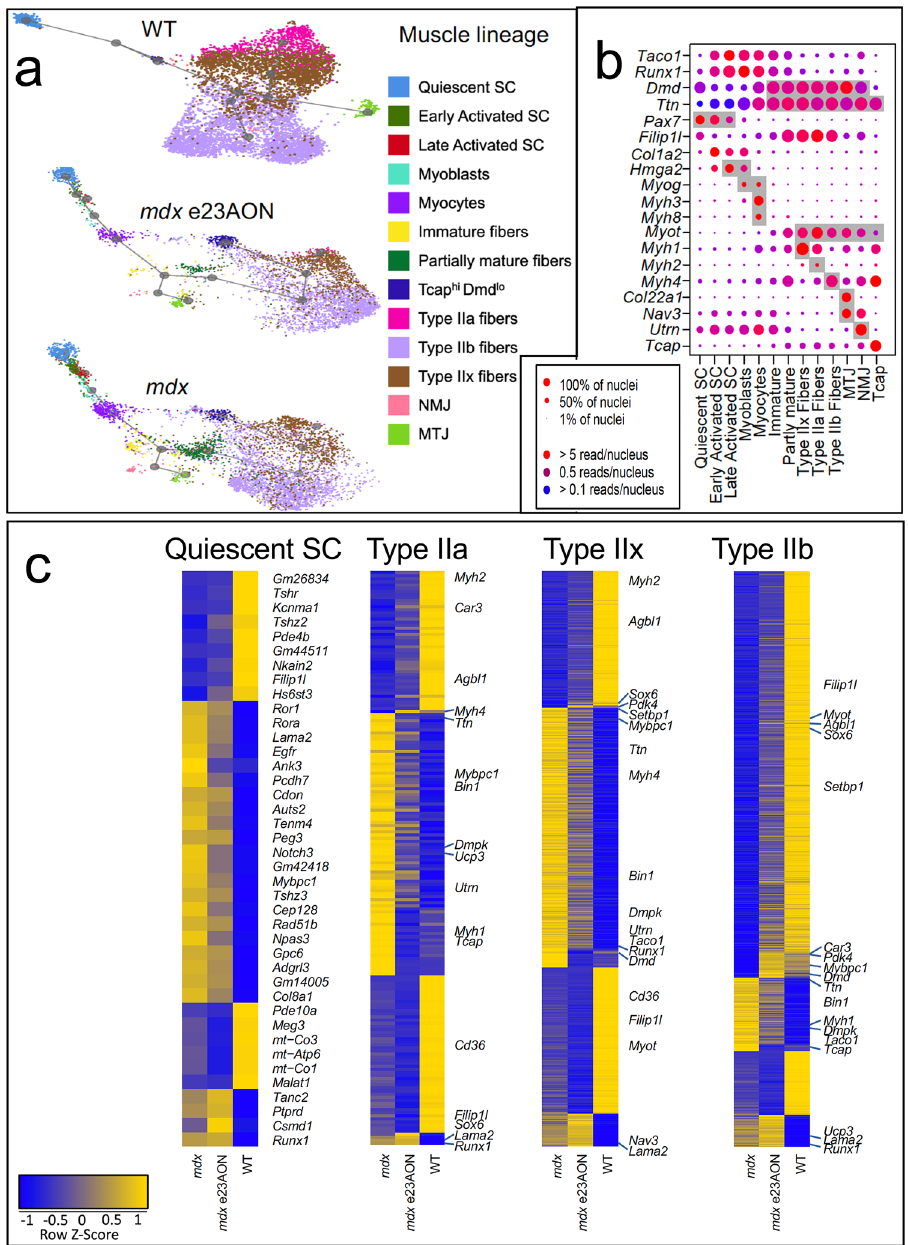
Fig. 3 Murine muscle lineage disease-related cell type and transcriptomic changes. a U-map pseudotime analysis and lineage tracing of muscle cell types was performed for WT ( n = 3), mdx e23AON ( n = 4), and mdx ( n = 4) nuclei. Muscle cell types are arranged according to their transcriptional relatedness and subcluster color is matched to legend for cell types shown in a and b . b Gene expression for selected genes distinguishing muscle cell subset populations plotted in a . Gray background indicates known markers of the respective cell type on x -axis. (Complete list of signi fi cantly different genes identifying each population is found in Supplementary Data 2). c Gene expression across treatment conditions is shown for select muscle cell/nuclei types. Yellow indicates higher gene expression. Heatmap of all genes signi fi cantly different between mdx and WT, demonstrates a strong trend toward a more WT pattern of expression in Satellite Cells, and Type IIa, IIx, and IIb myonuclei in e23AON-treated mdx